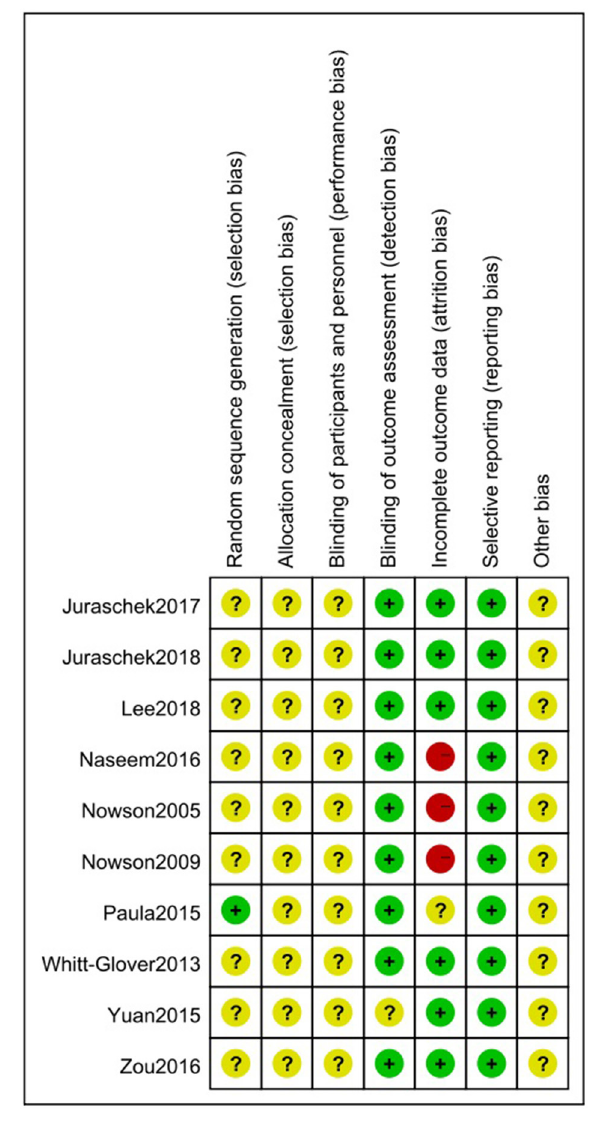
mmol/L), or HDL (MD: − 1.13 mmol/L) concentrations